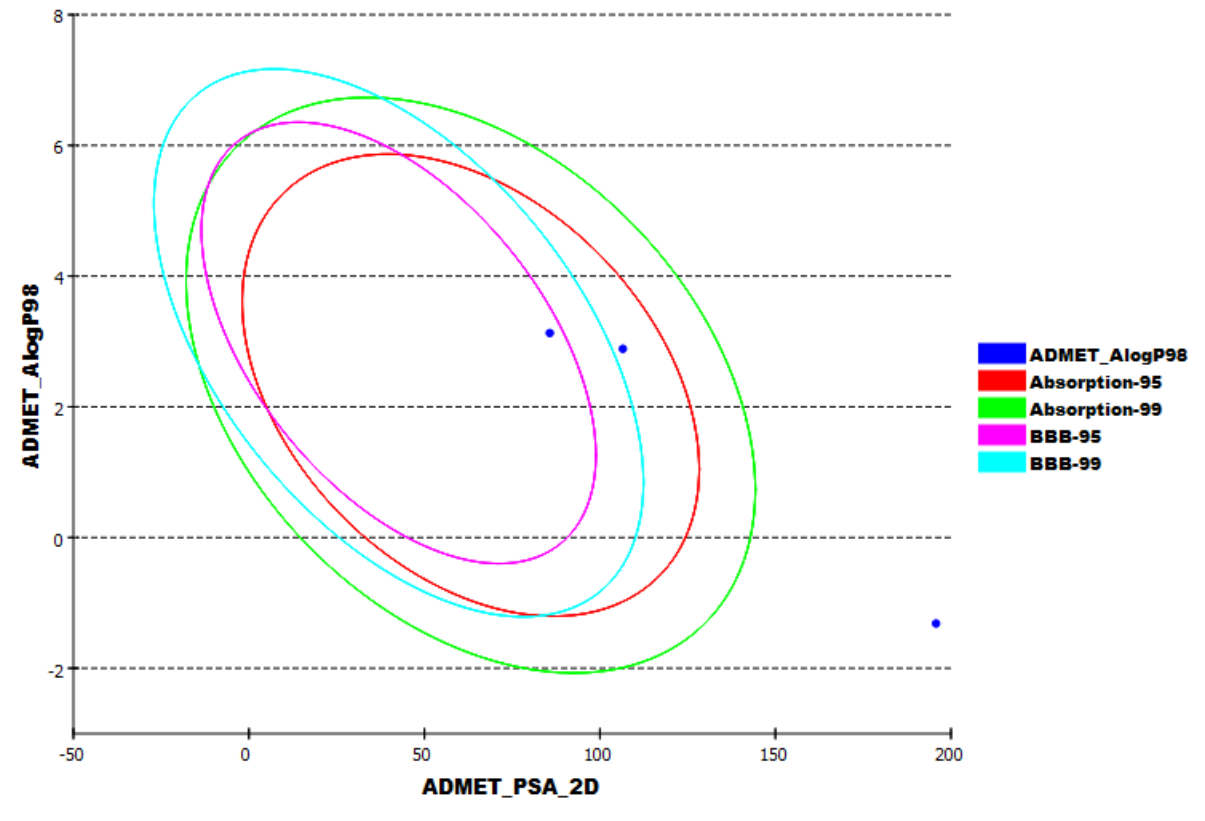
Figure 10. The expected ADMET study. Table 3. Binding free energies ( ∆ G in Kcal/mol) of the 6-demethoxy-4`-O-capillarsine ( 1 ), tenuflorin C ( 2 ) and TTT against PLP.